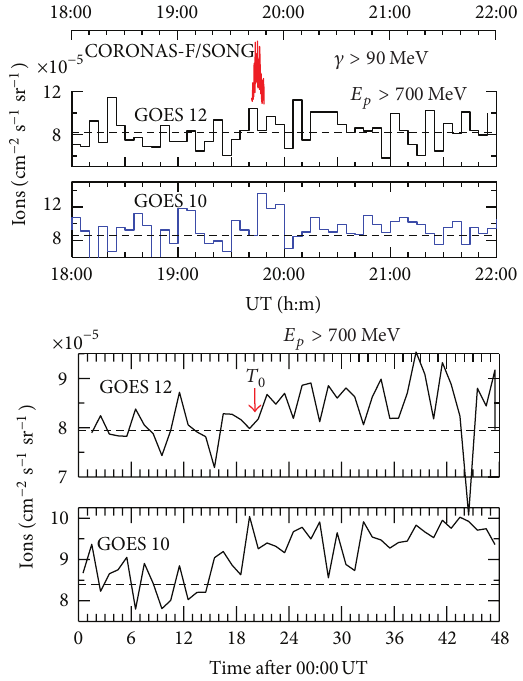
Figure 13: Time profiles of high-energy proton channels recorded by GOES-10 and -12 on November 4, 2003. Upper two panels: proton time profiles over 4 hours around the solar flare. Red curve in upper panel shows the increase observed in gamma-ray channel > 90MeV. Two lower panels: proton time profiles measured by HEPAD during enlarged time period. 𝑇 0 =